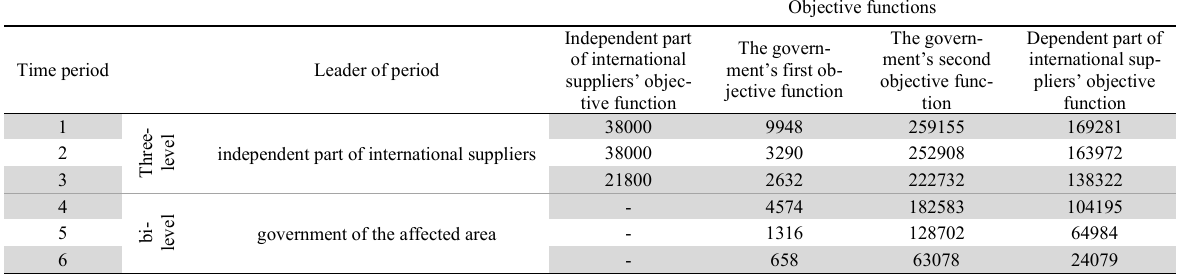
Objective functions